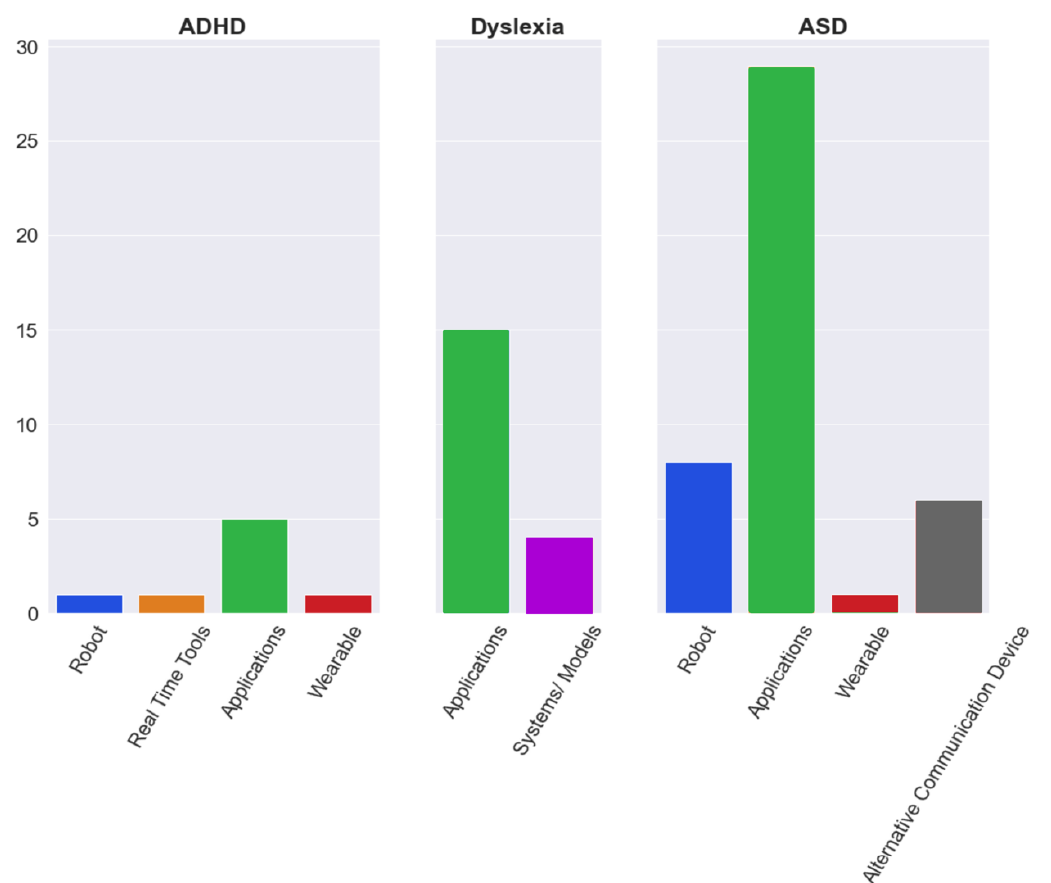
Figure 10. Bar graph representation of various assistive tools used to aid in the learning of ADHD, dyslexia and ASD students.